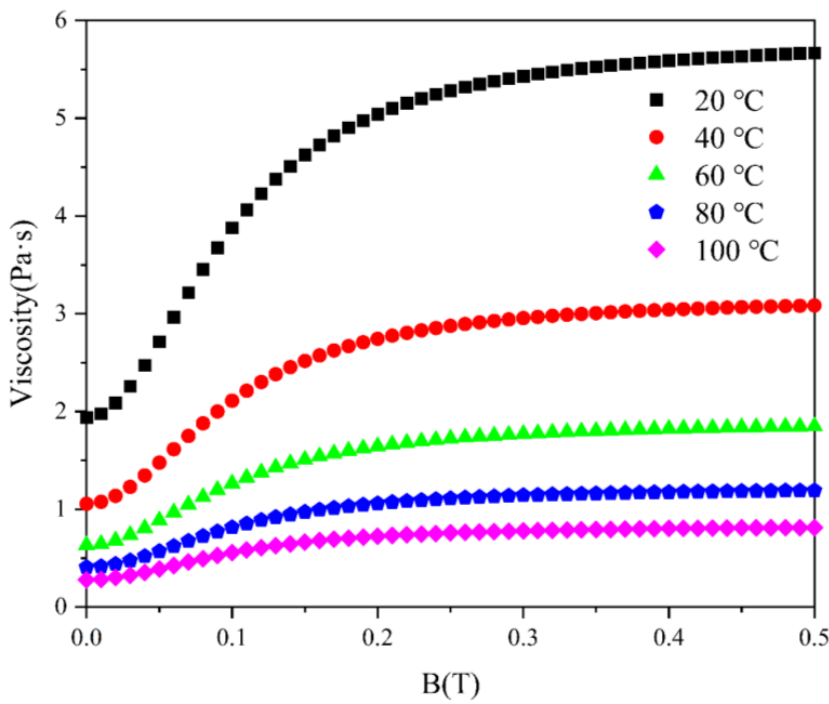
Figure 7. Viscosity relationship of magnetic fluid lubrication film under magnetic field.